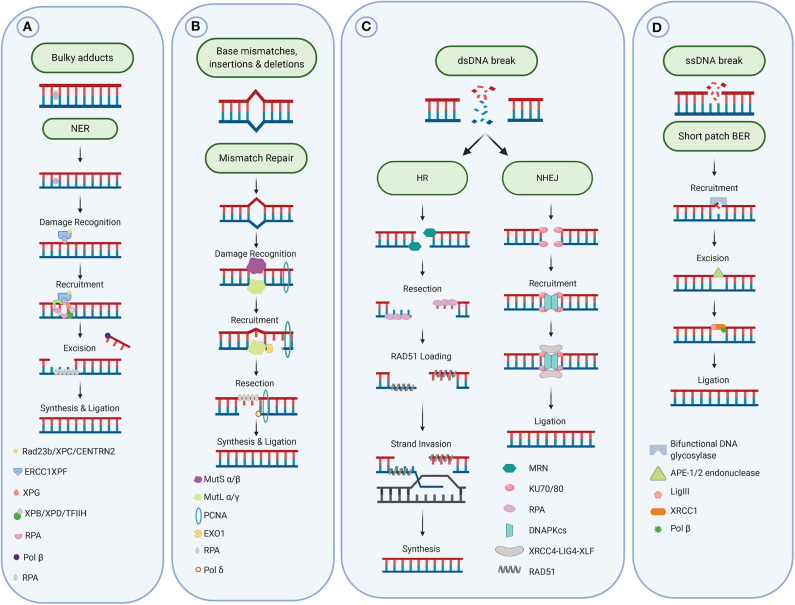
DNA repair pathways. (A) Repair of bulky adducts via the Nucleotide excision repair pathway. (B) Repair of mismatches via the mismatch repair pathway. (C) Repair of DNA double-strand breaks via the homologous recombination and non-homologous end-joining pathways. (D) Repair of DNA single strand breaks and damaged and oxidized bases via the base excision repair pathway. Figure created with Biorender.